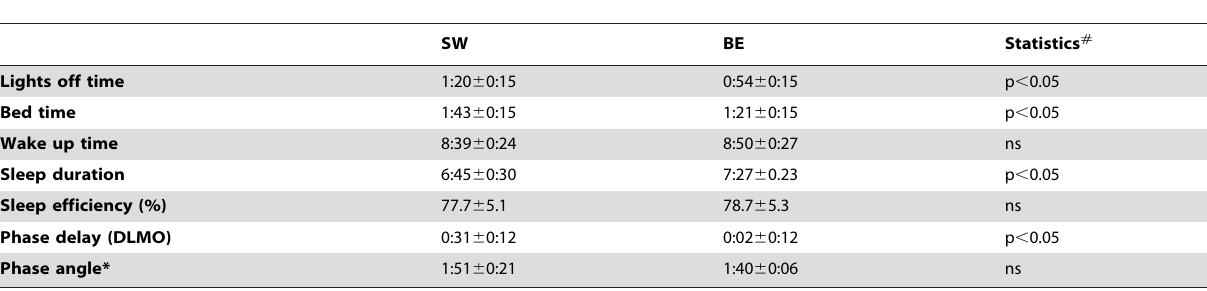
Table 2. Summary of sleep and phase shift results.